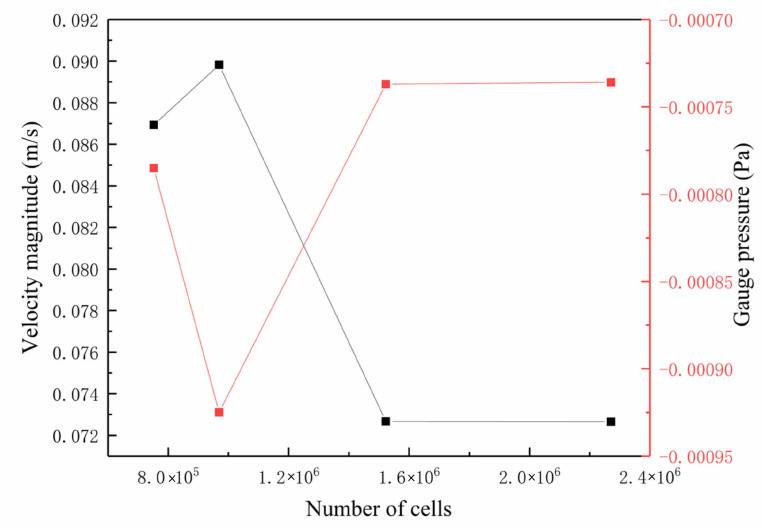
Figure 2. Mesh sensitivity analysis at the center of the farmers’ market.